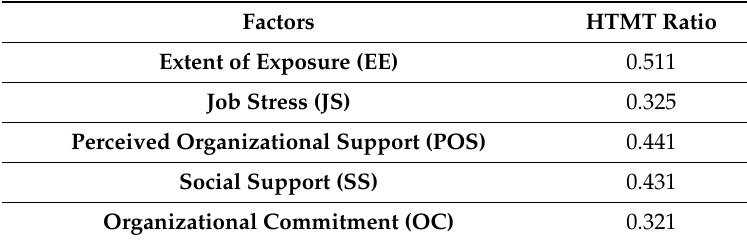
Table 2. Discriminant validity (by Heterotrait Monotrait—HTMT